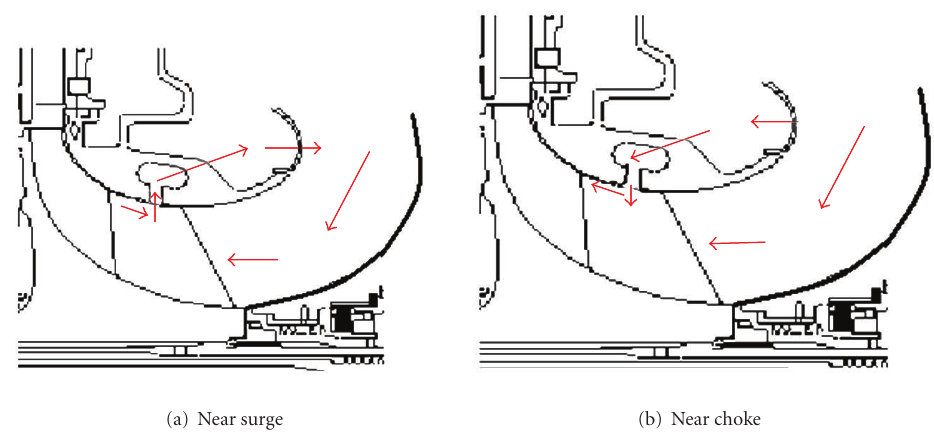
Figure 28: Ported shroud